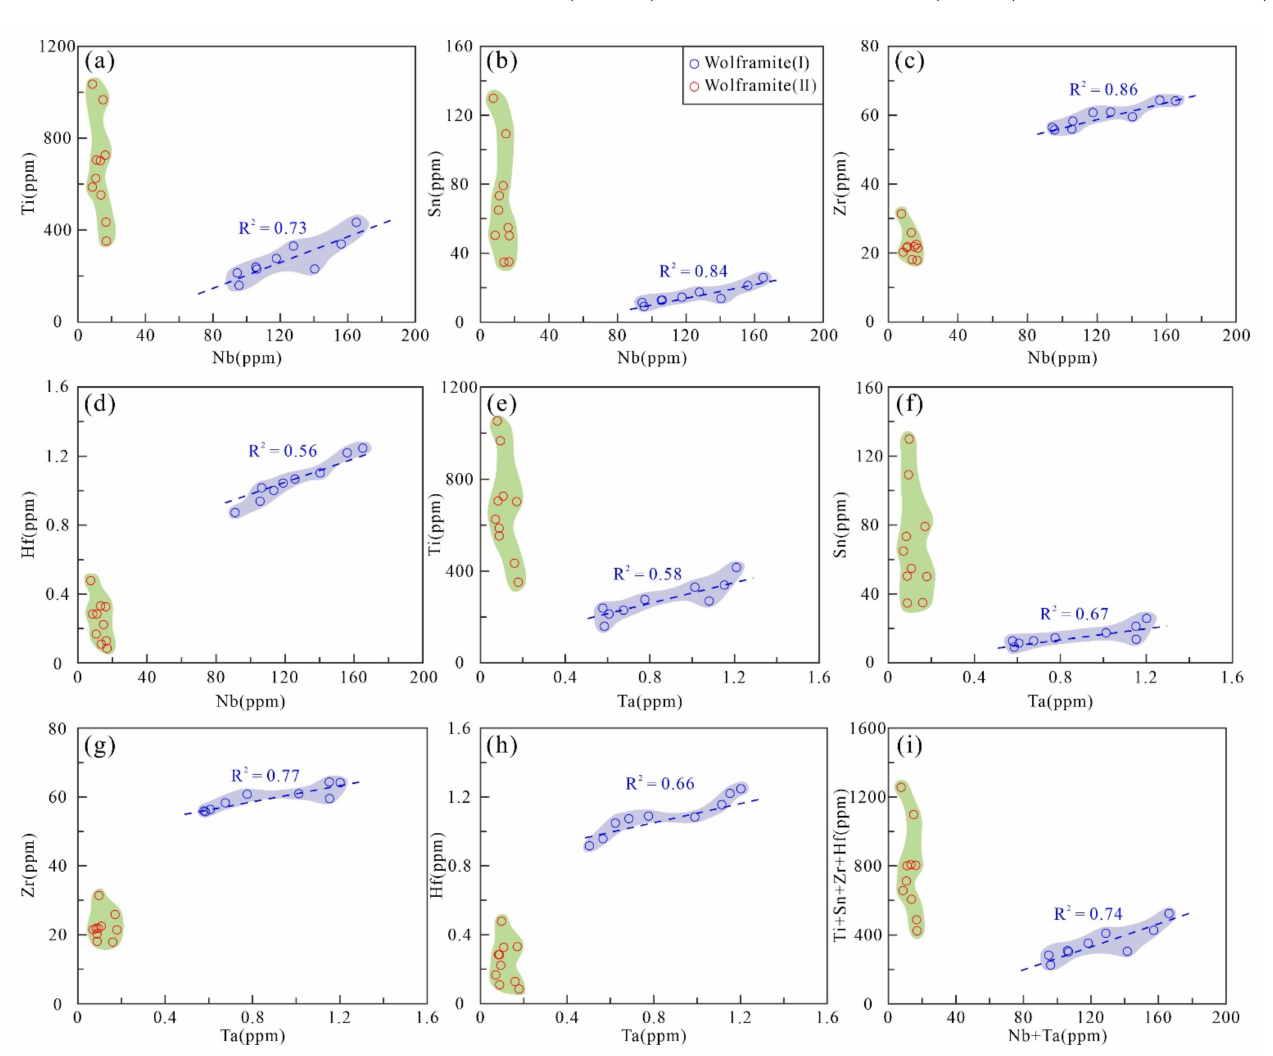
Figure 15. Correlation plots of tetravalent and pentavalent cations in two generations of wolframite from the Baishitouwa deposit. ( a ) Correlation plots of Nb and Ti contents; ( b ) Correlation plots of Nb and Sn contents; ( c ) Correlation plots of Nb and Zr contents; ( d ) Correlation plots of Nb and Hf contents; ( e ) Correlation plots of Ta and Ti contents; ( f ) Correlation plots of Ta and Sn contents; ( g ) Correlation plots of Ta and Zr contents; ( h ) Correlation plots of Ta and Hf contents; ( i ) Correlation plots of Nb + Ta and Ti + Sn + Zr + Hf